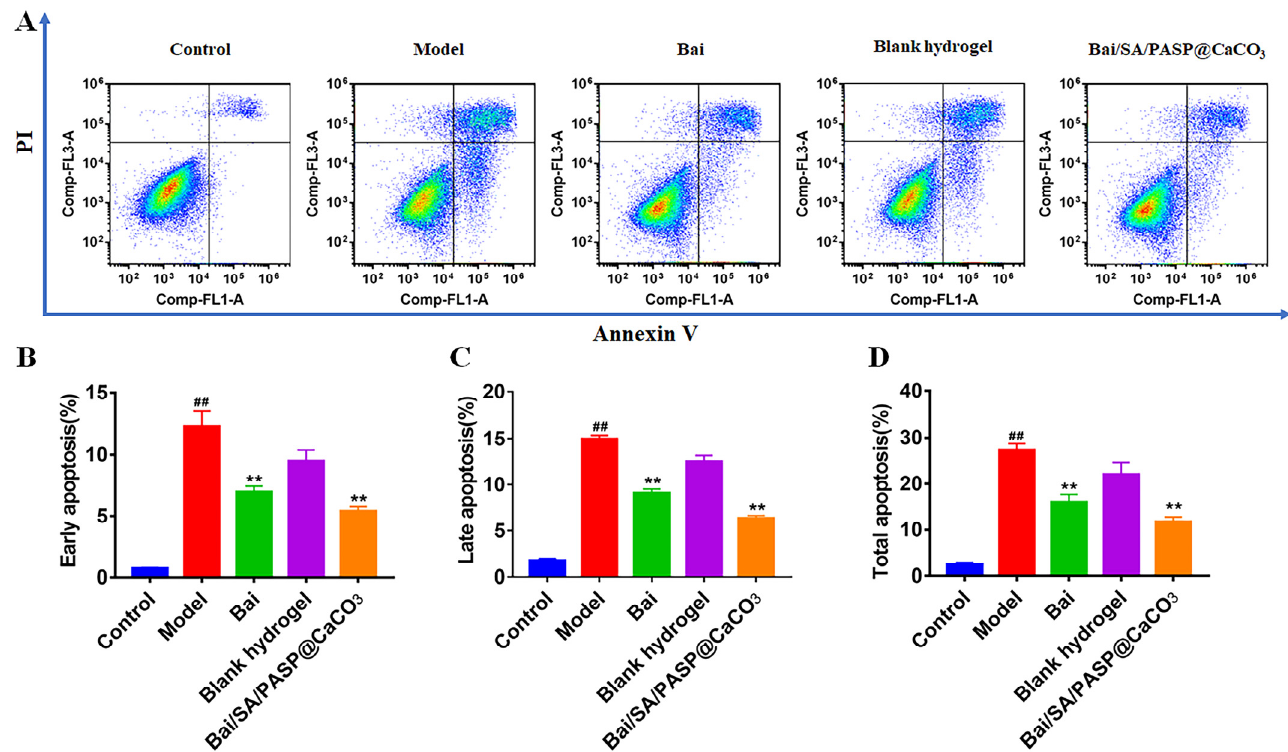
Figure 3. ( A ) Apoptosis rate of GES-1 cells was assessed with Annexin V-FITC/PI staining, and analyzed using flow cytometry. Quantitative analysis of early apoptosis ( B ), late apoptosis ( C ), and total apoptosis ( D ). Significant difference from the control group: ## p < 0.01; Significant difference from the model group: ** p < 0.01.